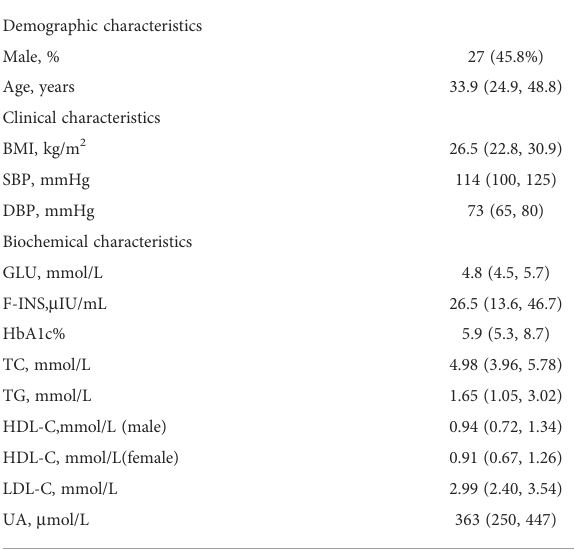
TABLE 1 Demographic, clinical and biochemical characteristics of adults with hypothalamic dysfunction